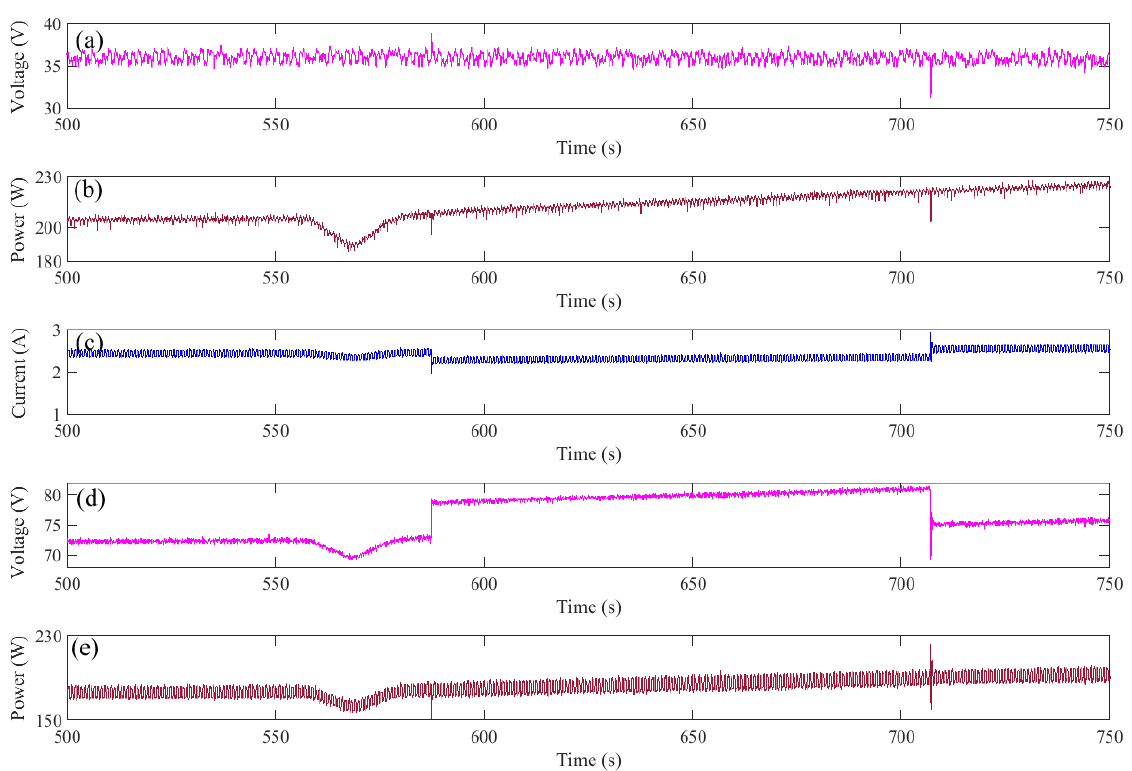
Figure 14. MPPT based on P&O: ( a ) Irradiation (W/m 2 ); ( b ) Temperature ( ◦ C); ( c ) Load resistance ( V out / I out ); ( d ) Duty cycle; ( e ) PV current.